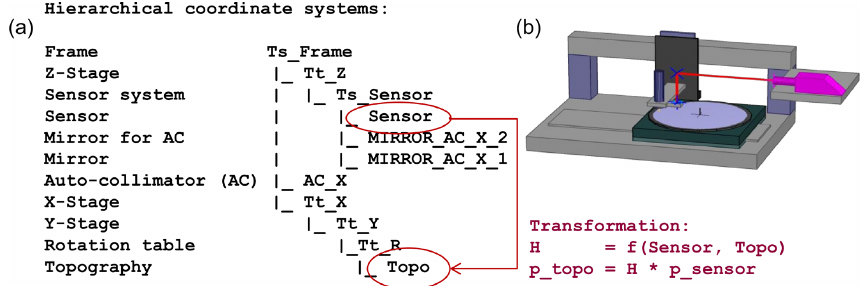
Figure 1. Example of the hierarchical structure of coordinate systems in SimOptDevice. (a) The plot of a coordinate system tree example is shown. The left column lists the element names; the right column shows a sketch of the hierarchical structure of the coordinate systems. (b) The corresponding instrument is illustrated. The position and orientation of each of the instrument’s subsystems are defined with re- spect to the superordinate system through a transformation of homogeneous coordinates. A transformation matrix H can be computed for transformations from one system to another (see Eq. 2). It is a function of the source system and the destination system (in this example Sensor and Topo , respectively). The common superordinate system Ts_Frame is needed for the computation of the transformation matrix (cf. Eq. 2). Subsequently, coordinates of a point in one system can be transformed to any other system by multiplication by the corresponding transformation matrix H .